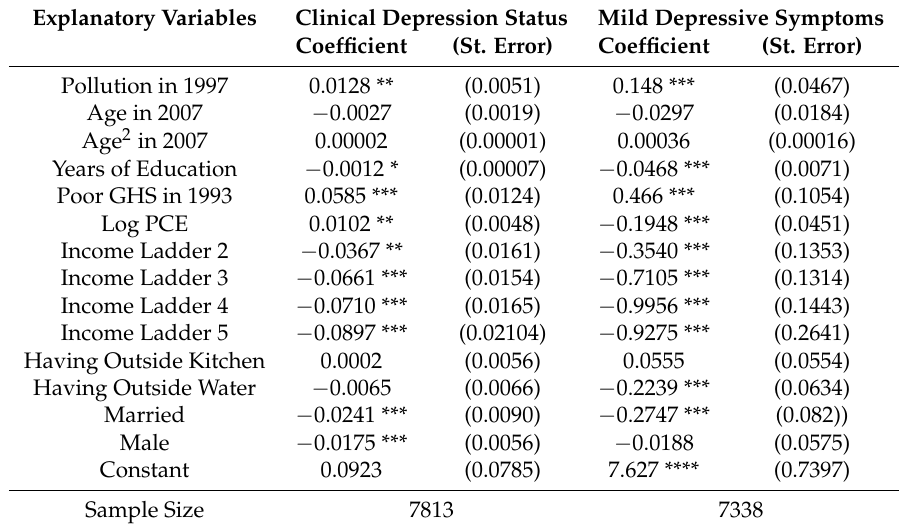
Table 5. Sub-sample analysis: Households exposed to smoke but not fires (OLS Regression